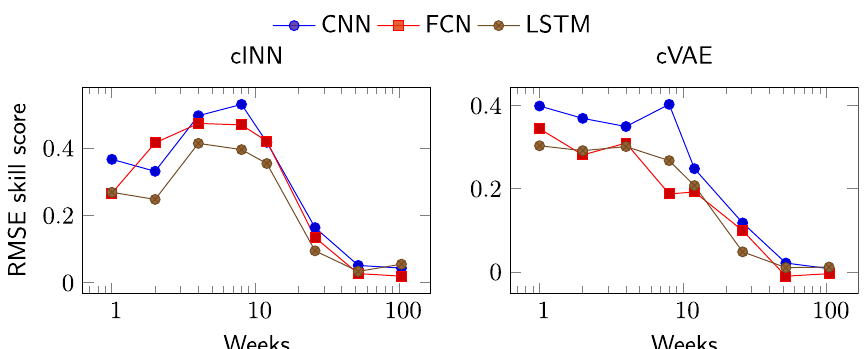
Fig. 8 The RMSE skill score of the three forecasting models applied with the LSFE given different amounts of available target data. The RMSE skill score considers the RMSE of the forecasting model trained using the LSFE as RMSE method and the RMSE of the forecasting model trained only on the available target data ( MT_124 ) as RMSE base . The LSFE is applied with the around seed noise sampling strategy and the combined data combination method for the cINN, and the shift seed noise sampling strategy and the fine-tune data combination method for the